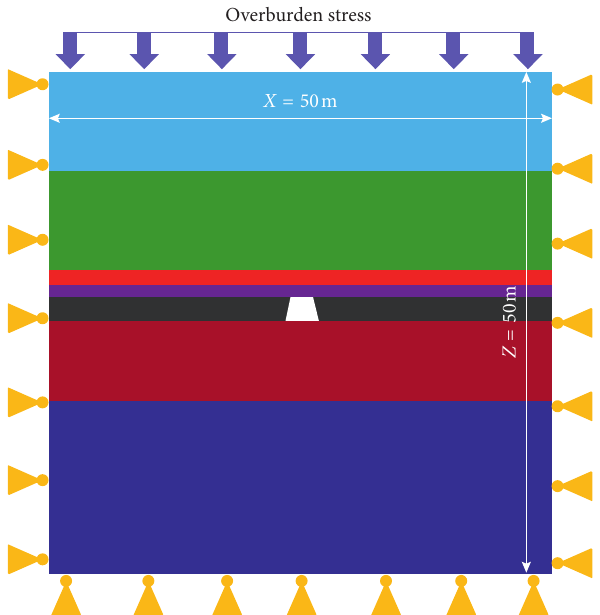
Figure 11: Three-dimensional numerical model of the 333 air